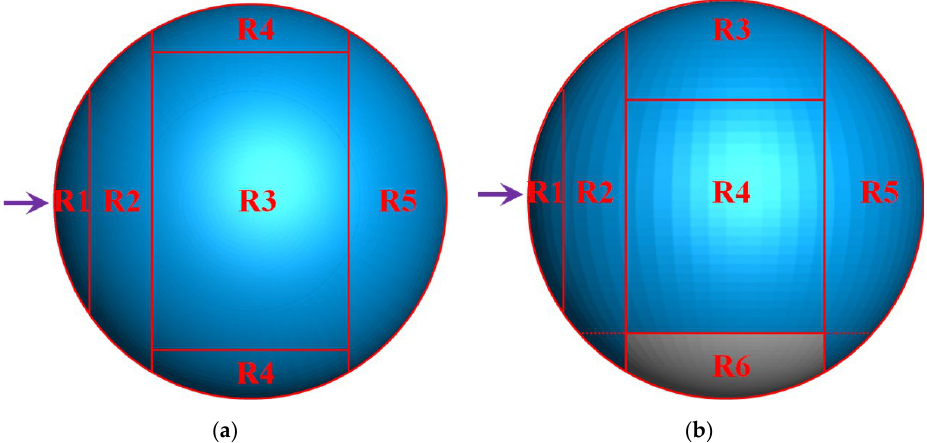
Figure 14. Suggested regional divisions for the wind loads on a spherical structure: ( a ) top view; ( b ) side view.